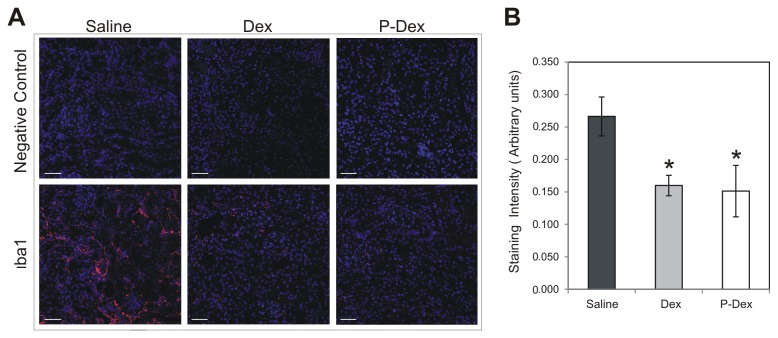
Impact of treatment on renal macrophage infiltration in (NZB × NZW)F1 mice.(A), Representative confocal images of immunohistochemical staining of kidney sections from mice in the saline (n=13), Dex (n=13), and P-Dex (n=9) treatment groups are shown. Sections were stained with an anti-Iba1 antibody (red) and DAPI (blue). Negative control (no Iba1 antibody) and merged images are shown. (B), Quantification of Iba1 staining is illustrated. Scale bars: 50 μm; the asterisk (*) indicates a statistically significant difference (P < 0.05) from the saline control group.